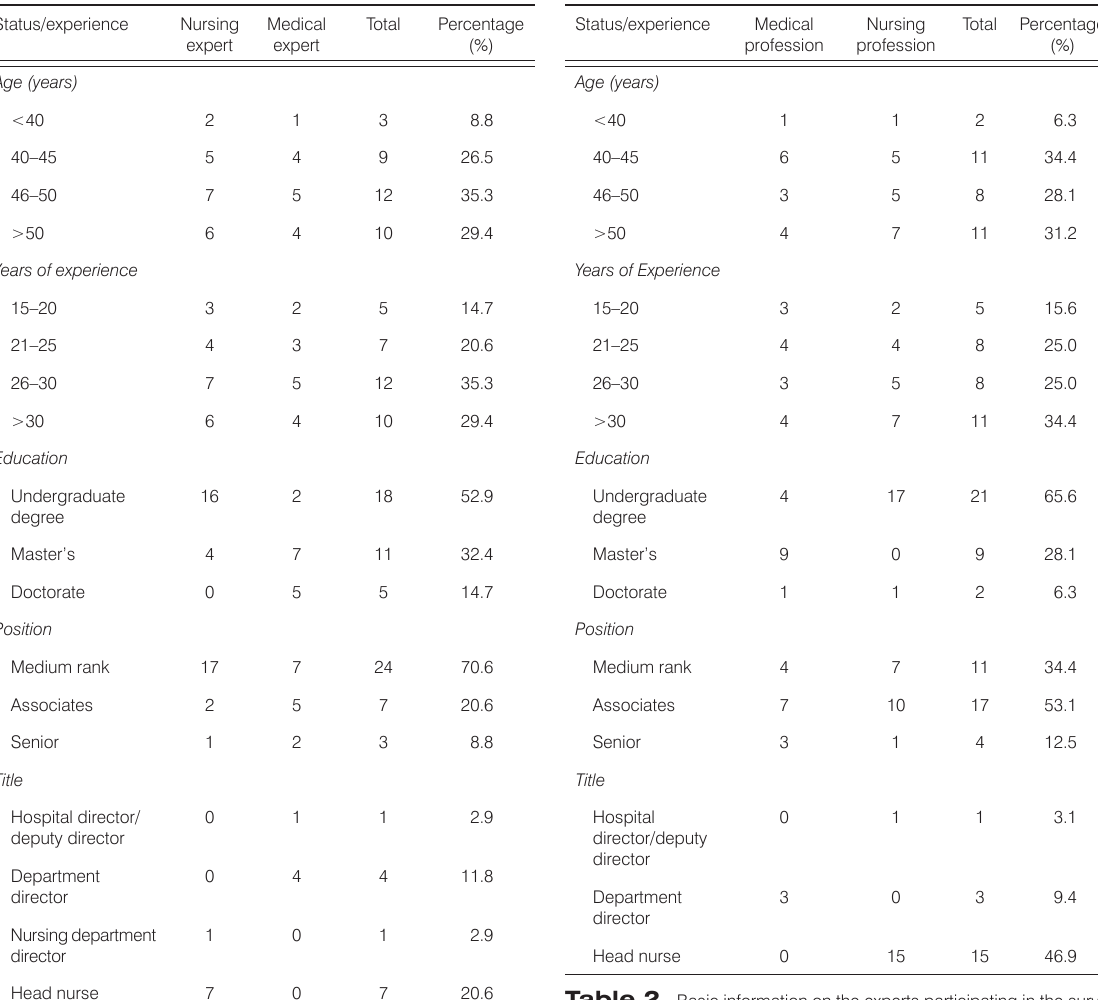
Table 2. Basic information on the experts participating in the survey on scope of practice of prescriptive authority for midwives in specific